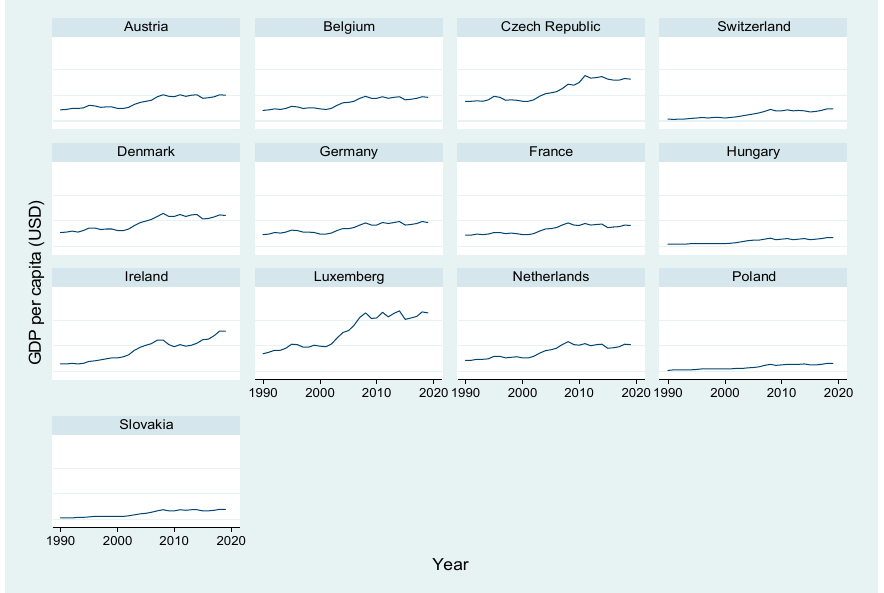
Figure 1. The trend of GDP per capita in the selected country during 1990 to 2019. Figure 2 shows that combustible energy and waste consumption patterns are growing over time. According to the curve trend, Denmark plays an essential role in combustible energy and waste consumption.